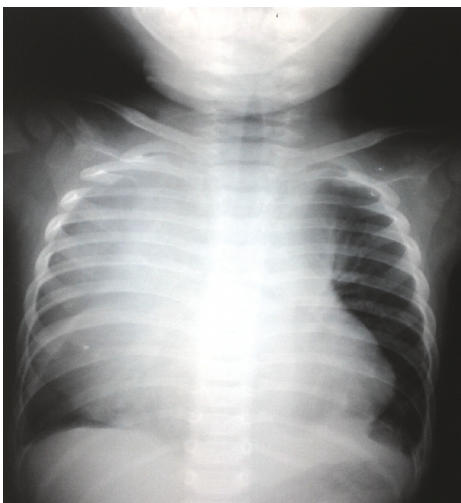
Figure 1: Chest radiography showing large homogeneous mediastinal opacity with mediastinal enlargement.